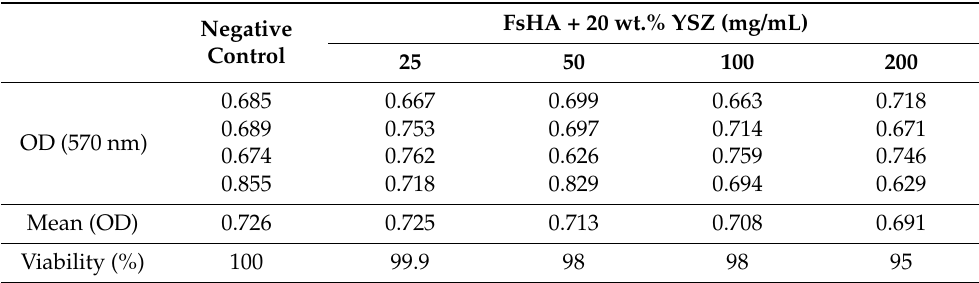
Figure 12. Percent cell viability at various concentration of the coated specimen. Figure 12. Figure 12: Percent cell viability at various concentration of the coated specimen. Table 5. OD and L929 cell viability values after 24 h of exposure to the coated specimen.